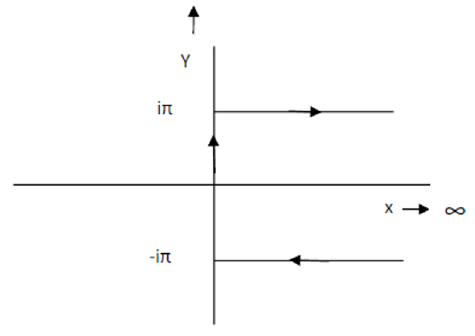
Figure 11. The contour for integration over t